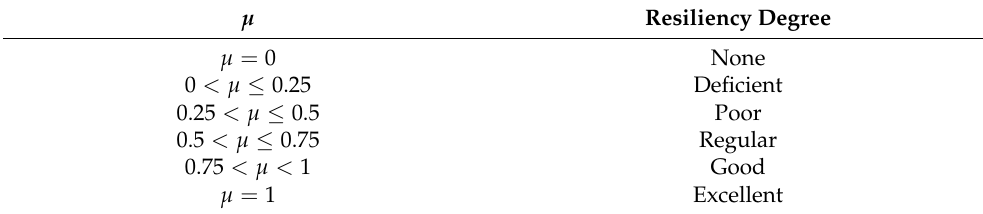
Table 1. Qualification of